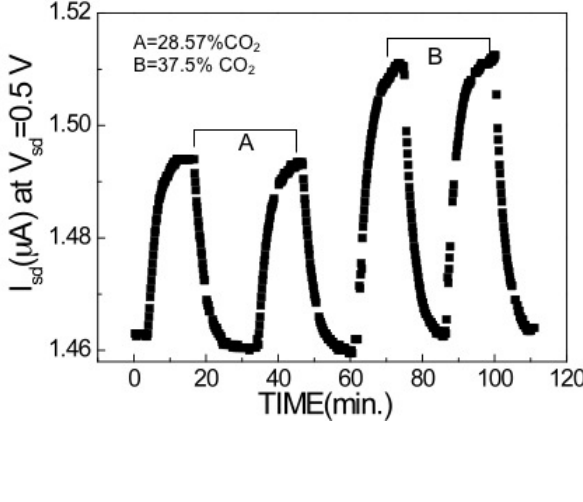
Figure 17. Drain current of PEI/starch functionalized HEMT sensor as a function of time measured at a drain bias voltage of 0.5 V and at 108 o